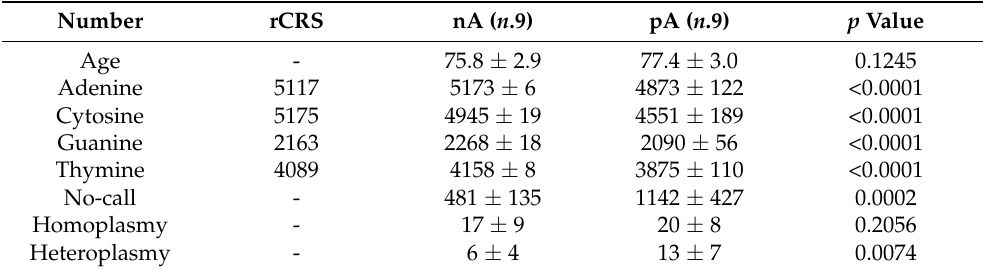
Table 5. Characteristics of mtDNA nucleotide sequences in age-matched